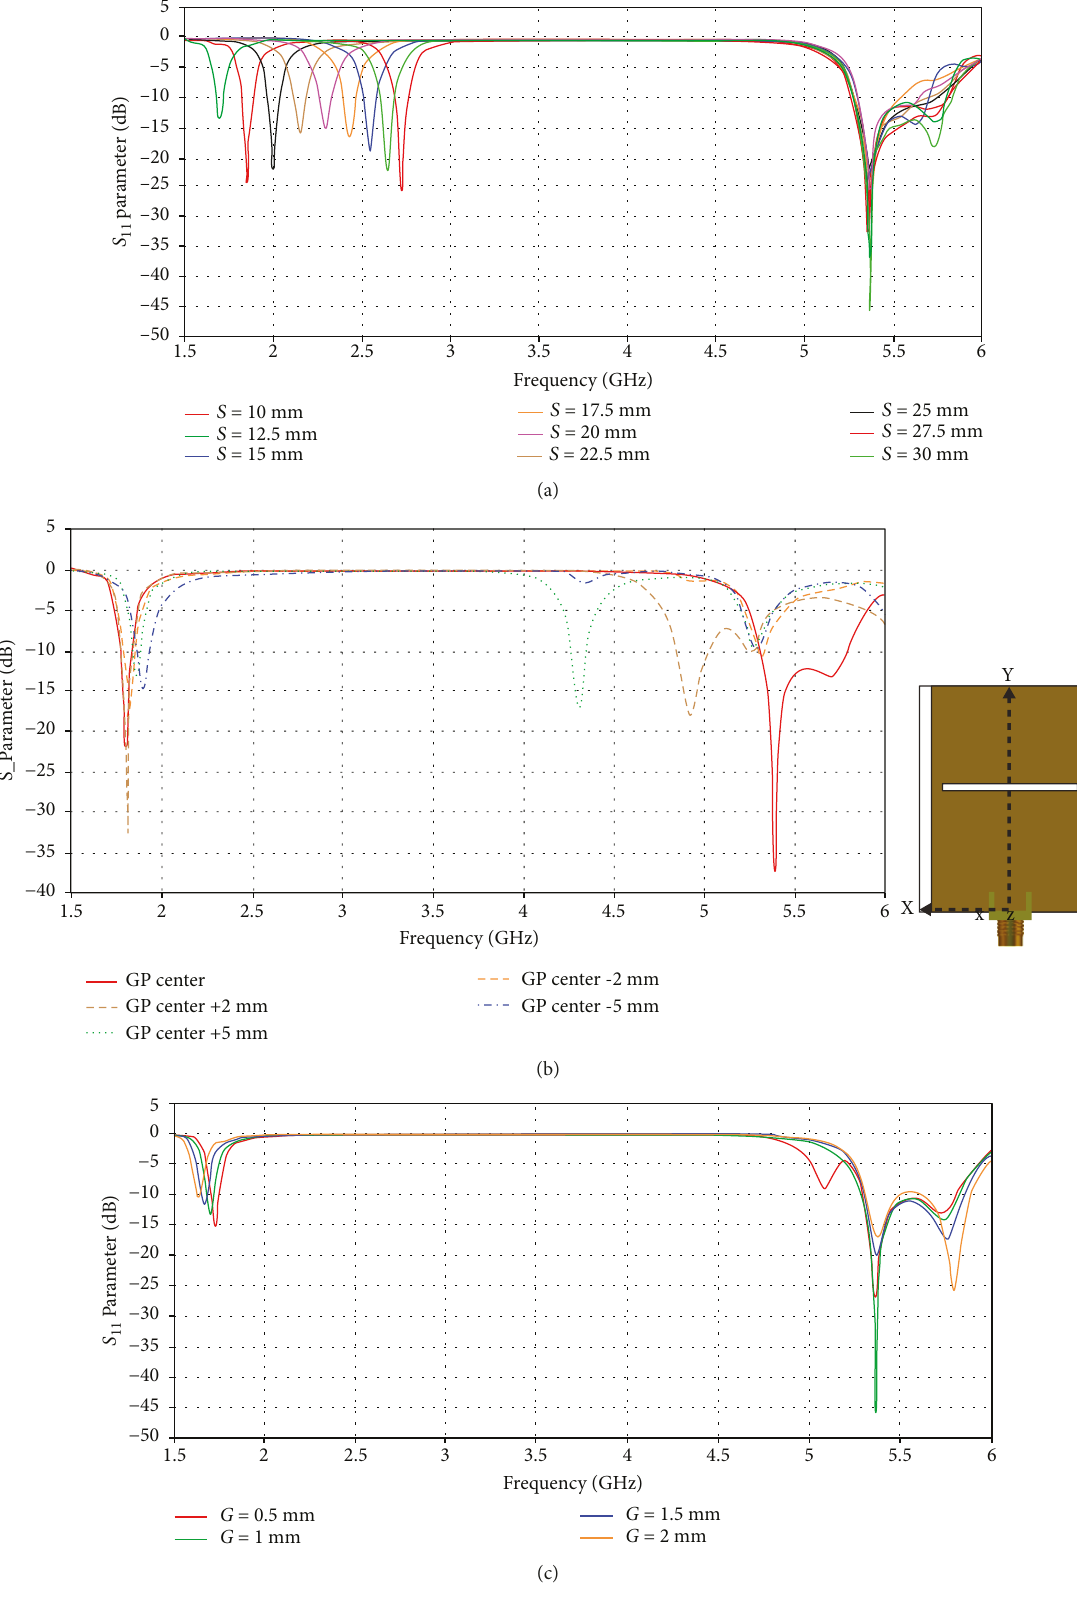
Figure 8: S 11 parameter variation with (a) the slot length ( S ), (b) the slot position along the y -axis ( GP center ), (c) the slot width ( g